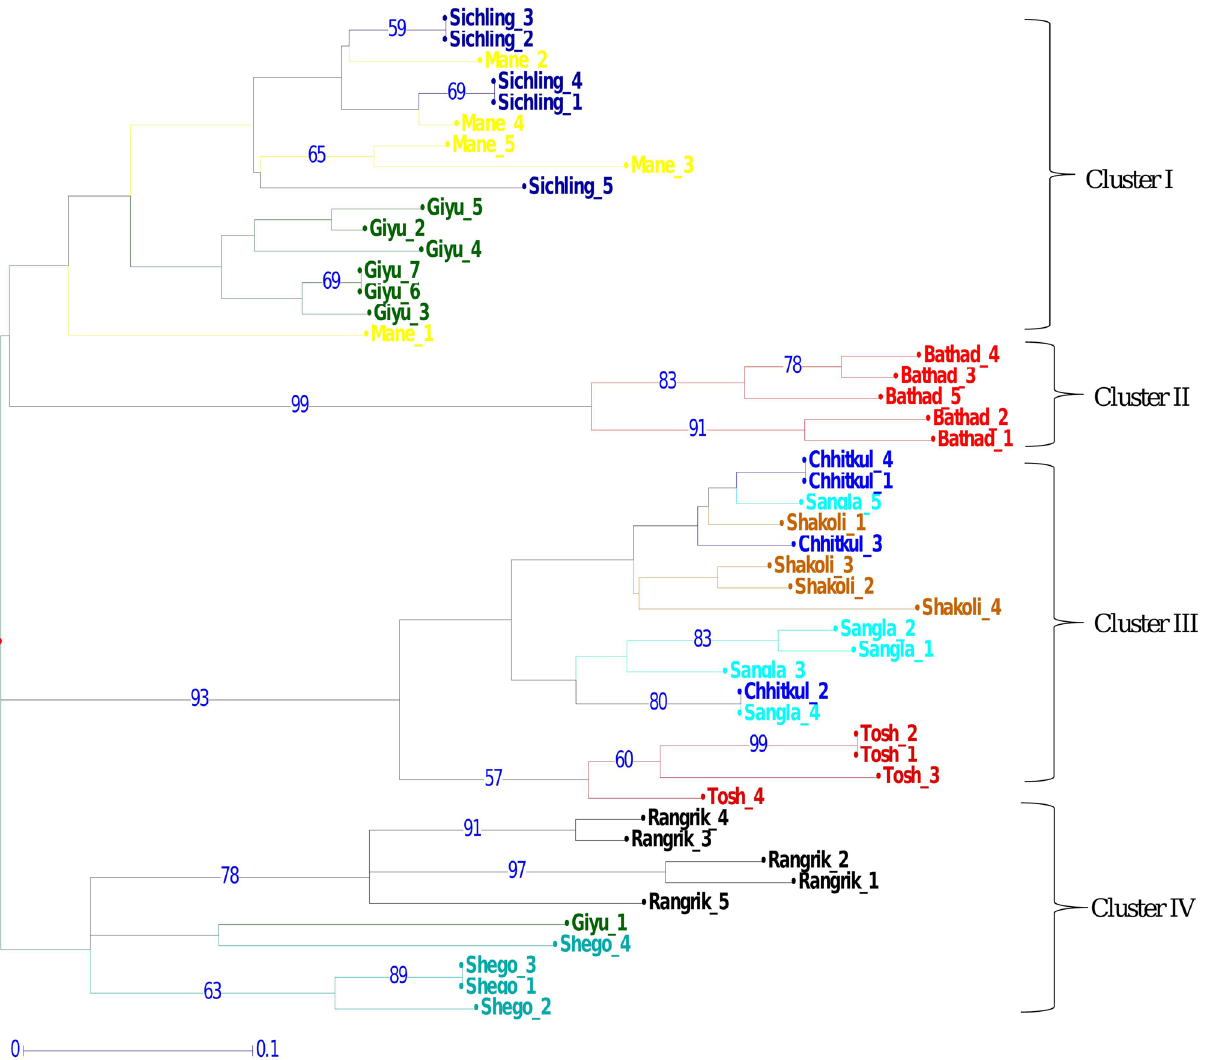
Figure 2. Dendrogram of 10 populations of Dactylorhiza hatagirea representing clustering of 48 individuals in four major